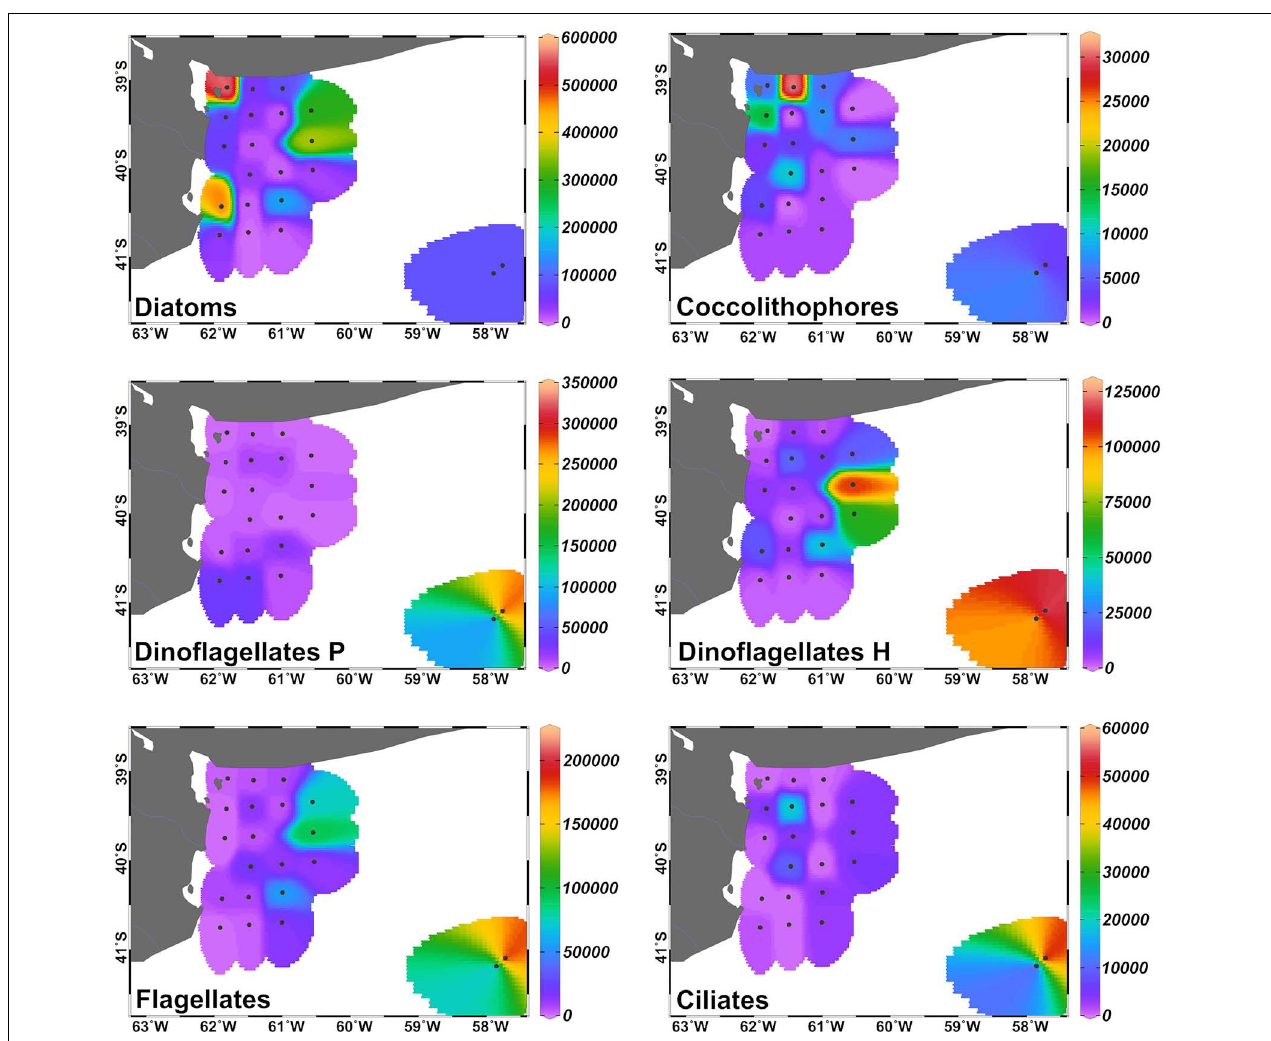
FIGURE 5 | Distribution of the abundance (in cells L − 1 ) of the main protists’ groups (cells > 5 µ m) in the inner-shelf and at the two middle-shelf stations in September 2015. Dinoflagellates P: phototrophic, dinoflagellates H: